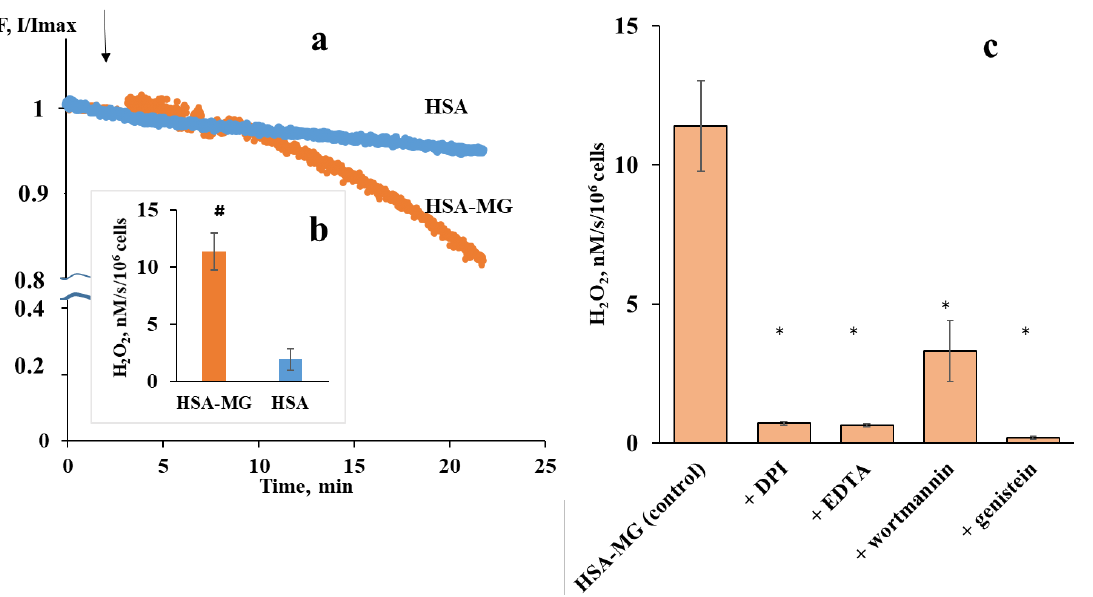
Figure 2. Typical kinetic curves of scopoletin oxidation by human neutrophils as a measure of H 2 O 2 generation in response to native HSA or HSA-MG ( a ); H 2 O 2 production by neutrophils as the rate of scopoletin oxidation ( b ); and the effects of DPI, EDTA, genistein and wortmannin on the rate of scopoletin oxidation by neutrophils in response to HSA-MG ( c ). DPI was used at a concentration of 20 μM; EDTA : 1 mM (experiments with EDTA were performed in PBS free of CaCl 2 and MgCl 2 ); genistein: 50 μM; and wortmannin : 100 nM. Cells were incubated with inhibitors or EDTA for 5 min at 37 °C, then HSA-MG was added. The concentration of HSA and HSA-MG was 25 µg/mL. Data are presented as the means ± SEMs, n = 5 – 6. # p < 0.05 vs. HSA; * p < 0.05 vs. the effect of HSA-MG.